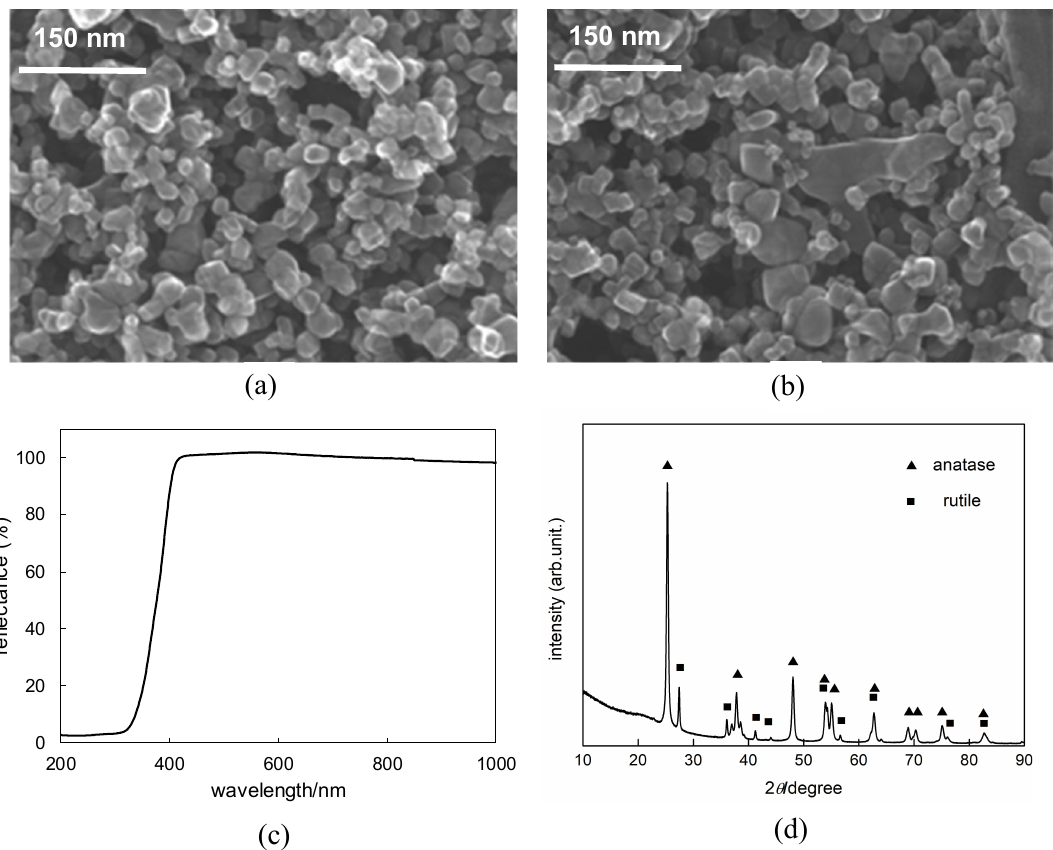
Figure 2. Characteristics of P25 photocatalysts: ( a, b ) SEM images, ( c ) Diffuse reflectance spectrum (DRS), and ( d ) XRD pattern .